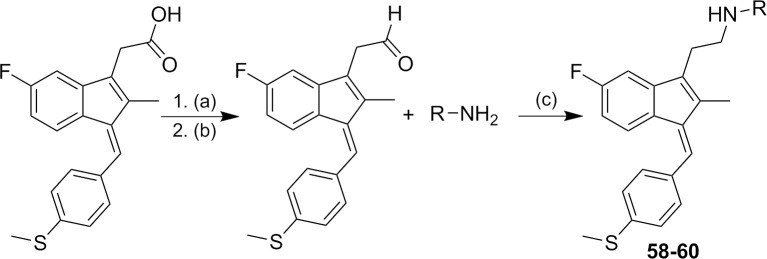
Synthetic pathways to analogs 58–60.Reagents and conditions: (a) MeOH, SOCl2 (b) DIBALH, Toluene (c) NaBH4, MeOH, rt.